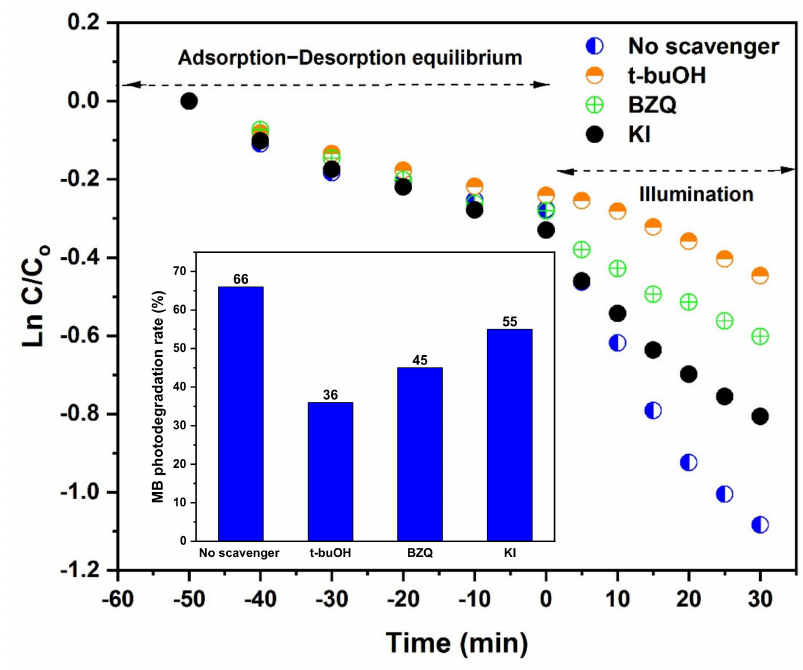
Figure 12. E ff ects of the various radical scavengers on MB photodegradation.